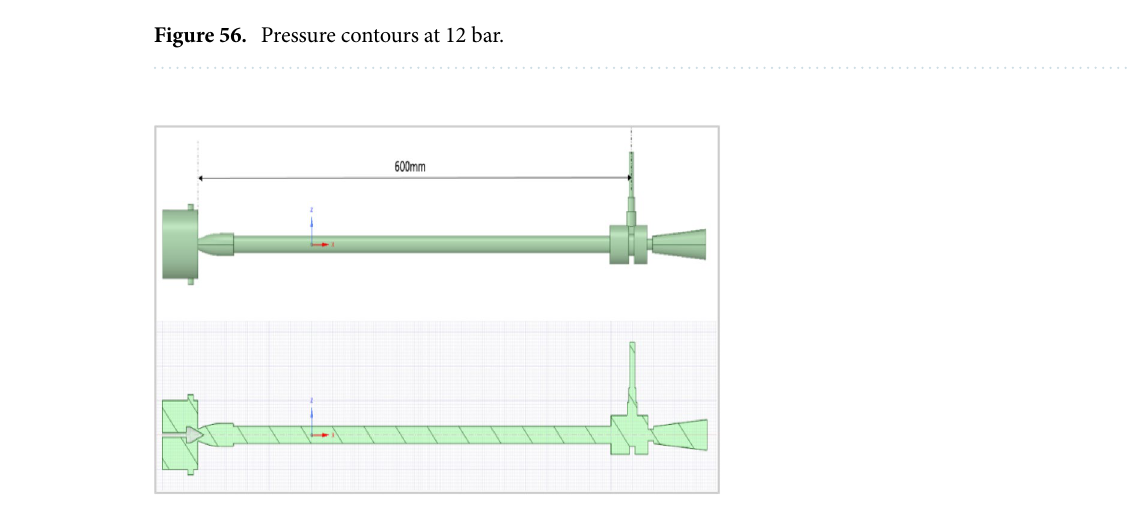
Figure 57. Vortex tube CAD details.